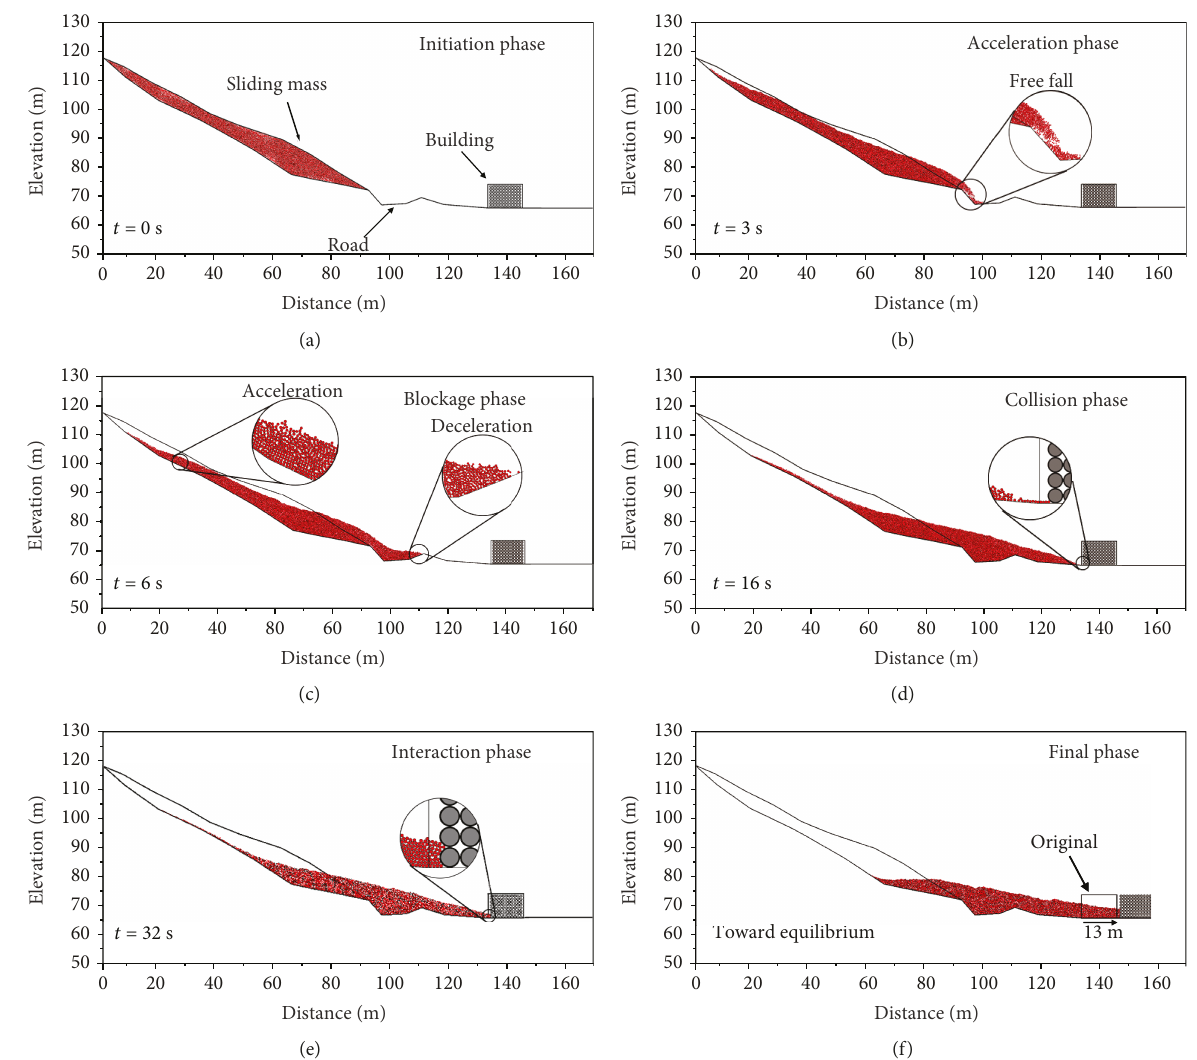
Figure 14: The kinematic process of Yanchao mudstone landslide: (a) the initiation phase, (b) the acceleration phase, (c) the blockage phase, (d) the collision phase, (e) the interaction phase, and (f) the fi nal